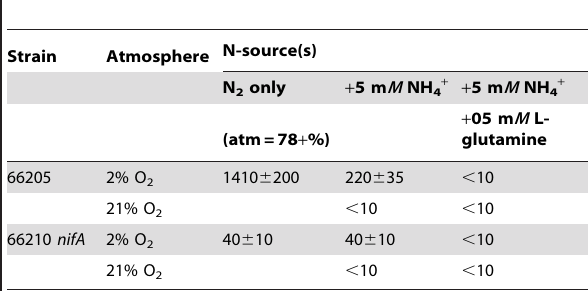
Table 3. A caulinodans hyq operon expression; P hyqR b - glucuronidase reporter